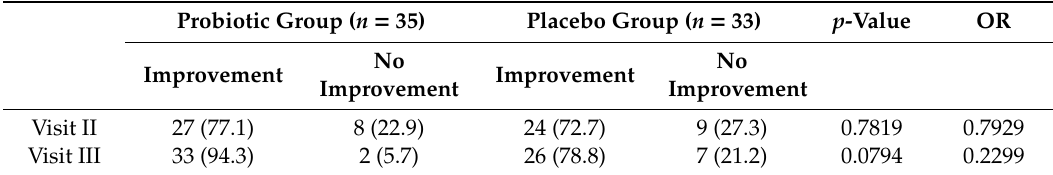
Table 5. The e ff ect of synbiotic treatment on the global improvement of IBS